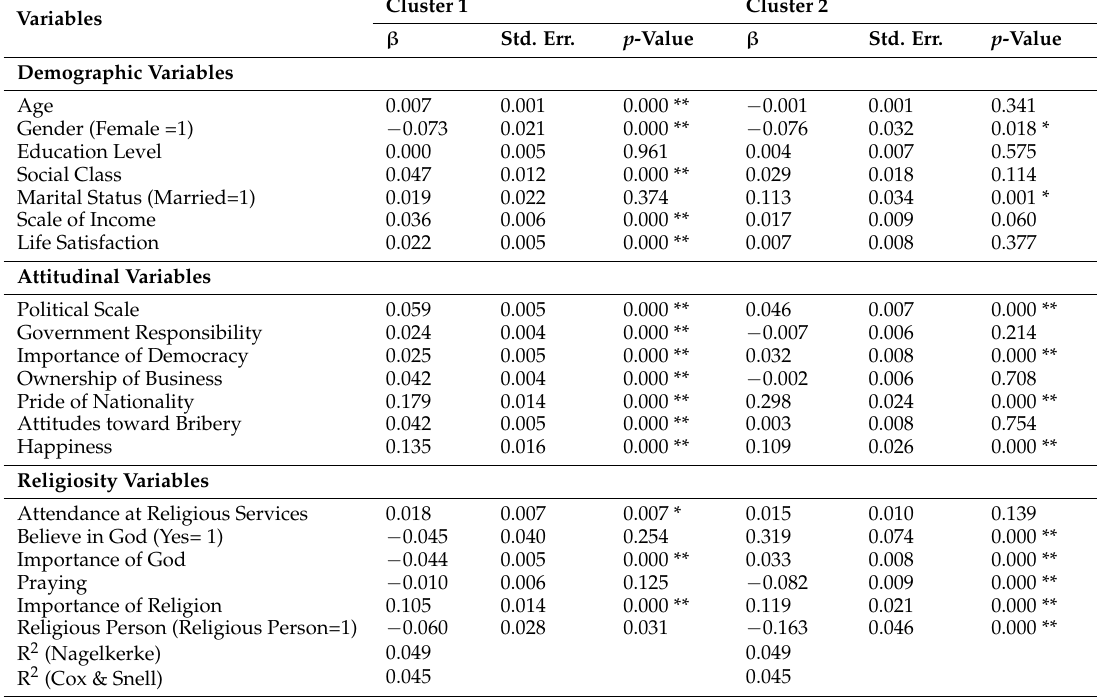
Table 5. Ordered logistic regression results of the clusters: Confidence in